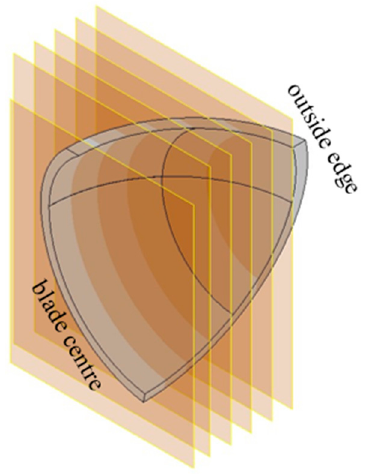
Figure 18. Distribution of interstitial planes over half of the blade. In order to investigate the trade-off that occurred between exit angles that focused flow towards the center of the blade and those that tended to result in a more even flow film leaving the blade, two blades were generated with inverted distributions of angles going from the center to the outside edge. One blade had angles that increased from the